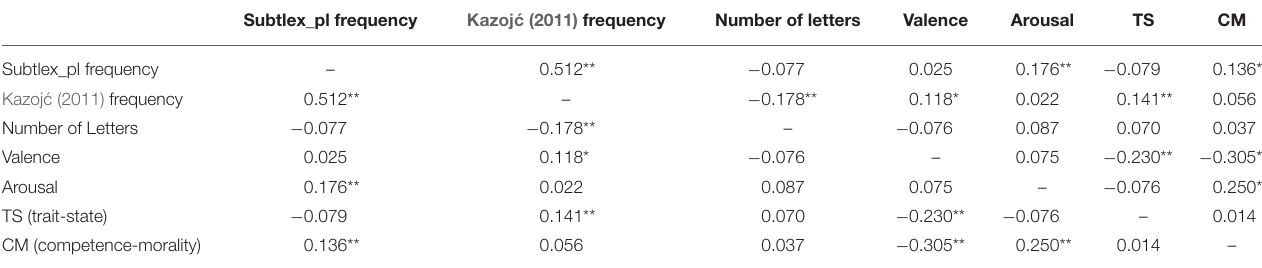
TABLE 4 | r-Pearson correlations between the